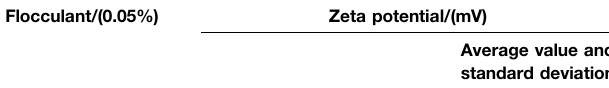
Average value and standard